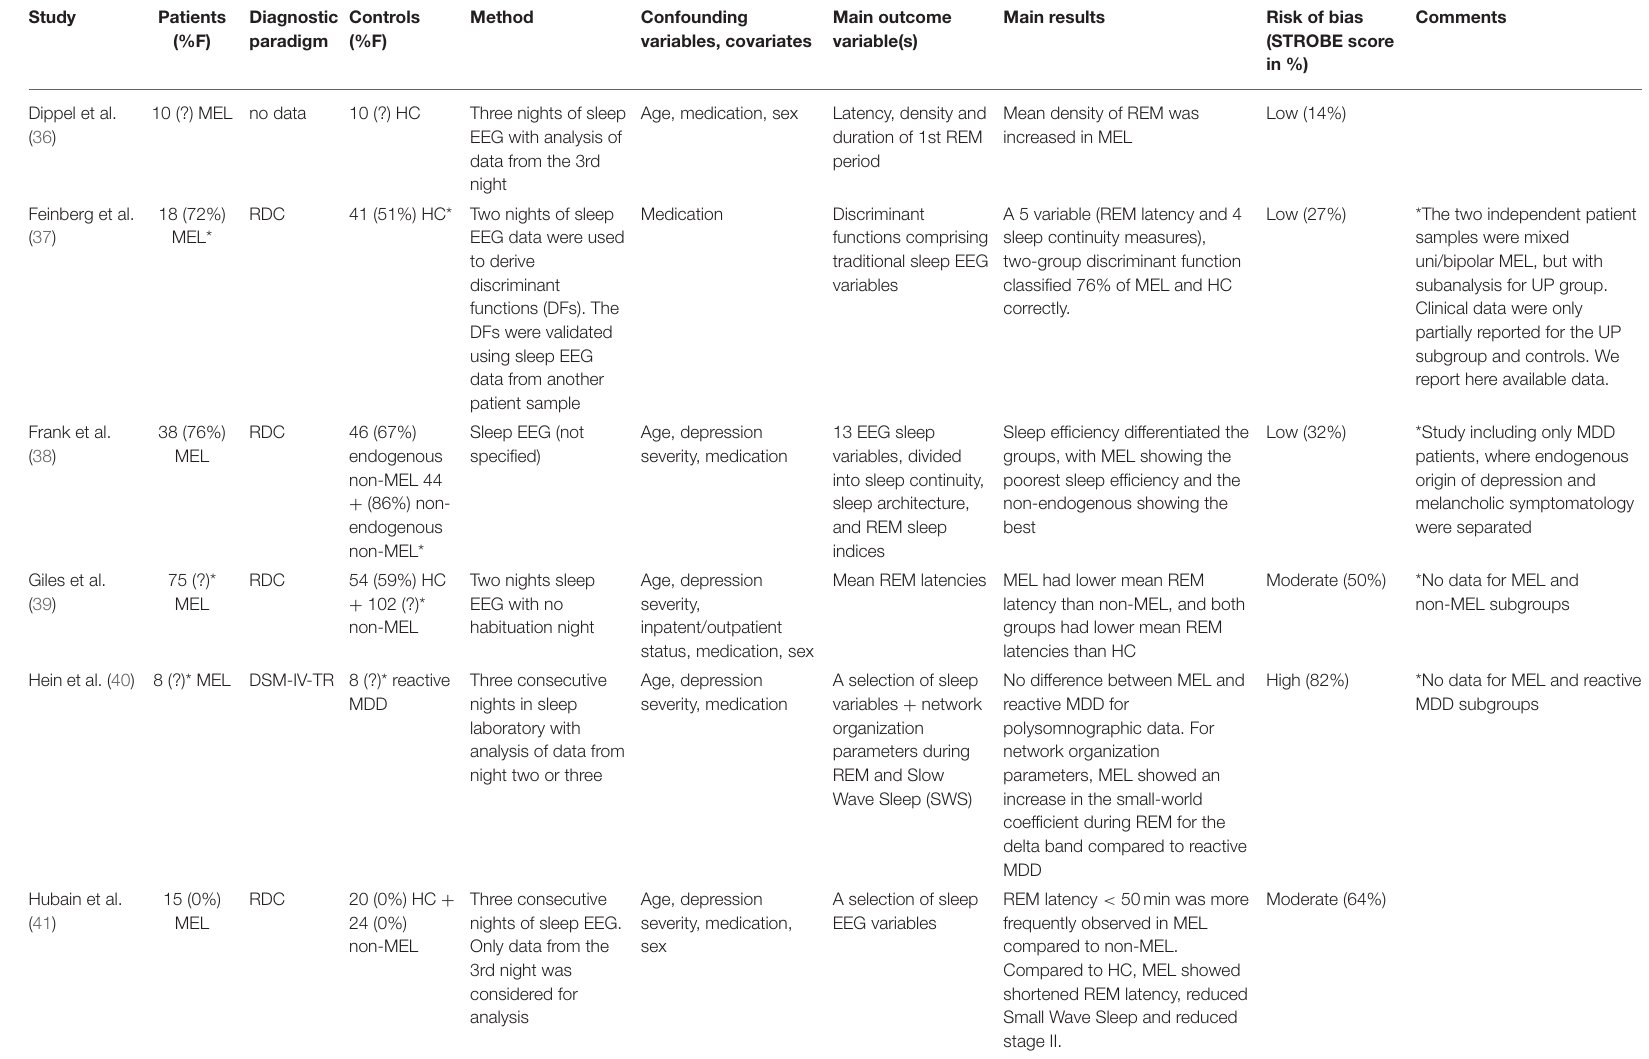
TABLE 1C | Summary of sleep EEG